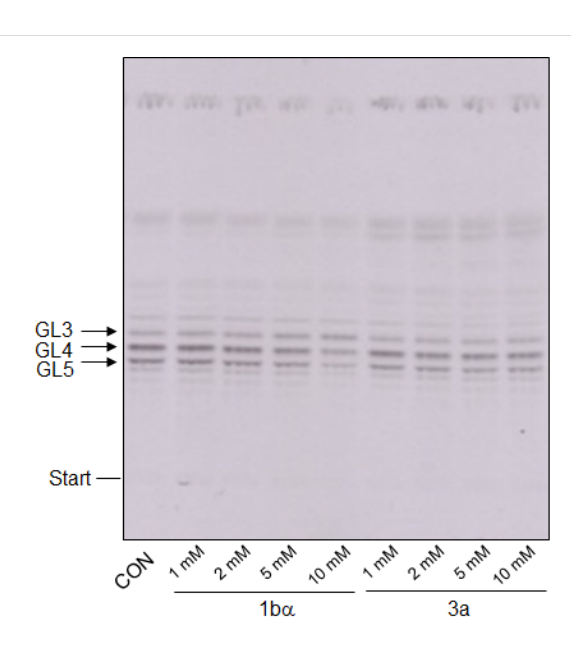
Figure 4: TLC analysis of the dose effects of the compounds 1b α and 3a on production of lower lipid-linked galactan precursors. CON, control; GL3–GL5, glycolipids 3–5. GL3 and GL4 are the products of GlfT1, GL5 is produced by GlfT2.